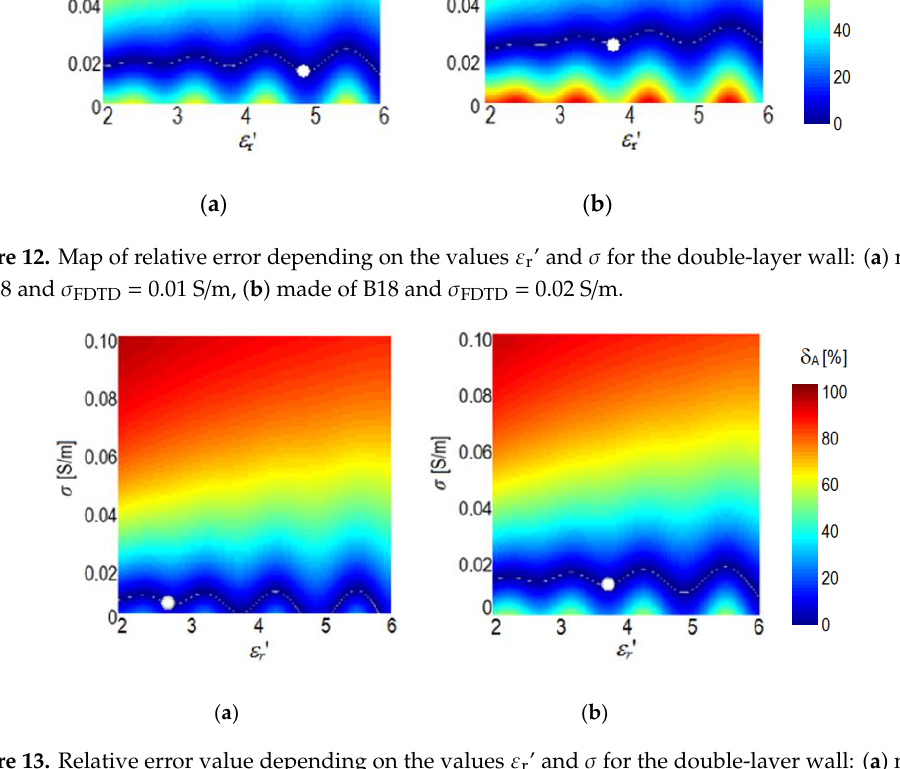
Figure 13. Relative error value depending on the values ε r ’ and σ for the double-layer wall: ( a ) made of B30 and σ FDTD = 0.01 S / m, ( b ) made of B30 and σ FDTD = 0.02 S / m.